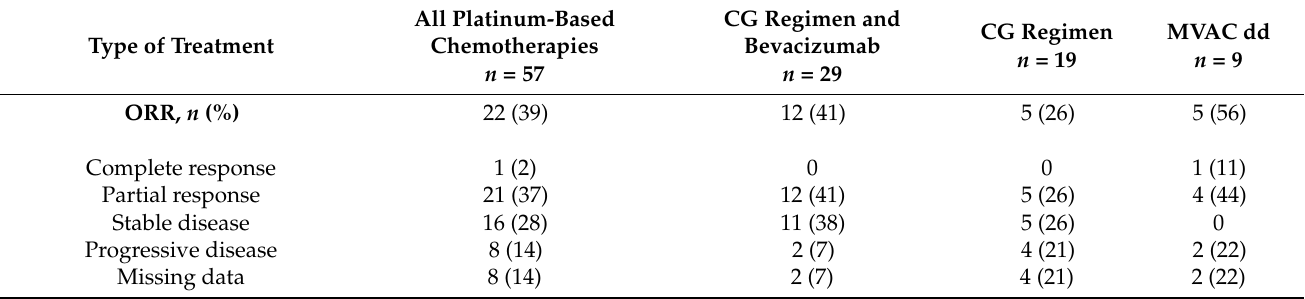
Table 2. Clinical response with first-line